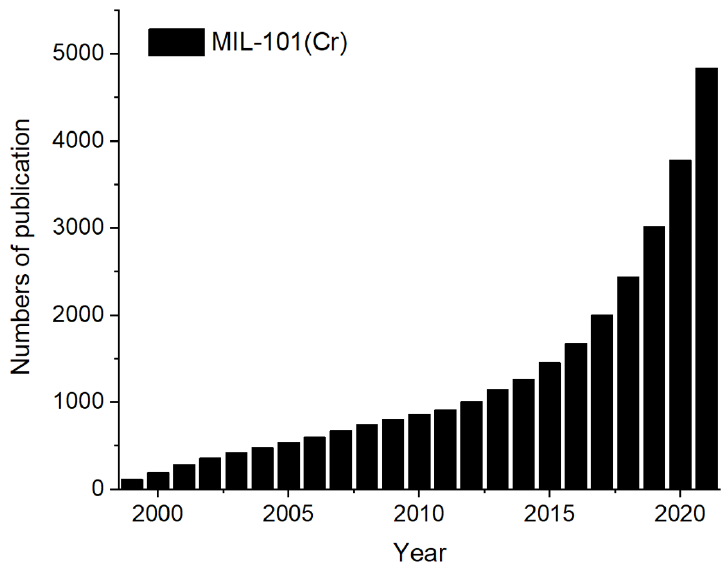
Figure 1. The statistics of scientific articles on ‘MIL - 101(Cr)’ since 1998 (data from